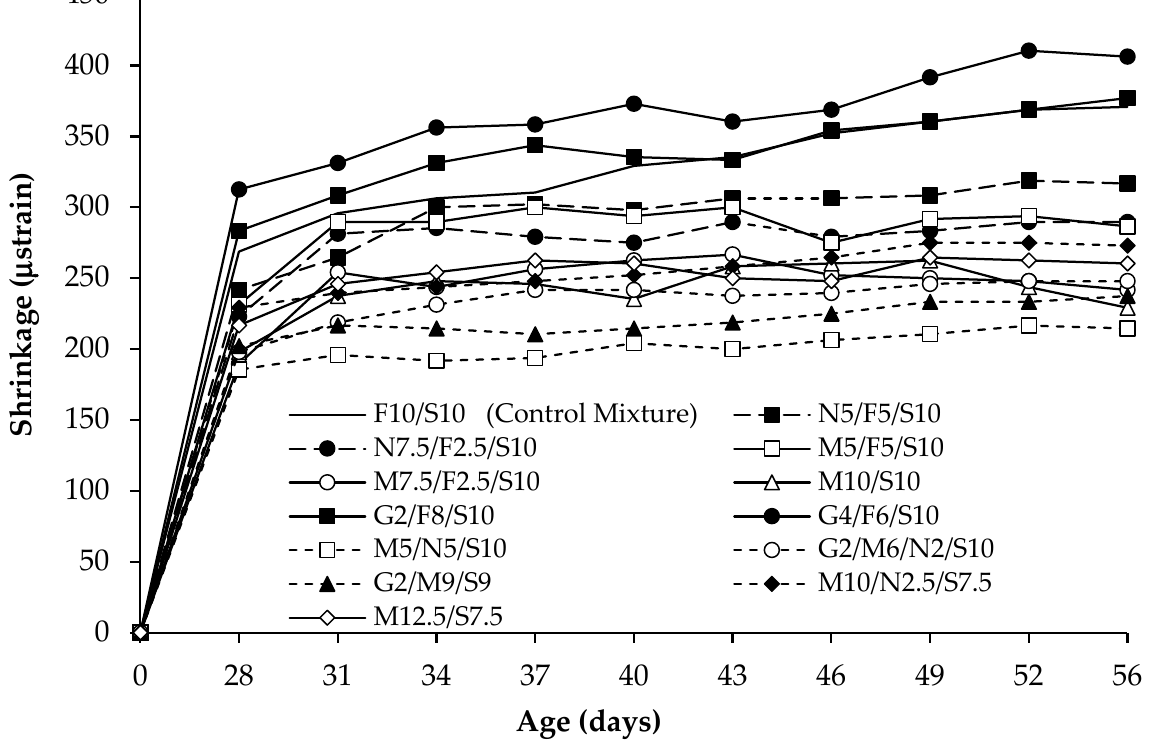
Figure 8. Shrinkage results.